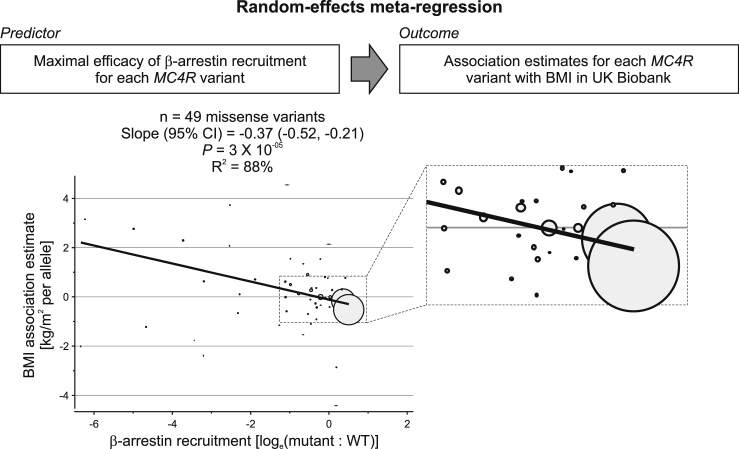
β-Arrestin Recruitment by Different MC4R Variants Explains a Significant Proportion of the Variance in Their Association with BMIModel (top) and results (bottom) from a meta-regression analysis in which β-arrestin recruitment for each MC4R mutant was the predictor and association estimates for BMI were the outcome. Circles represent each variant, with circle size proportional to the weight of each variant in the model. The enlarged box shows the area where variants with the largest weight clustered. CI, confidence interval; BMI, body mass index. Sensitivity analyses excluding the two variants with the largest weight and leave-one-out analyses are in Table S5.